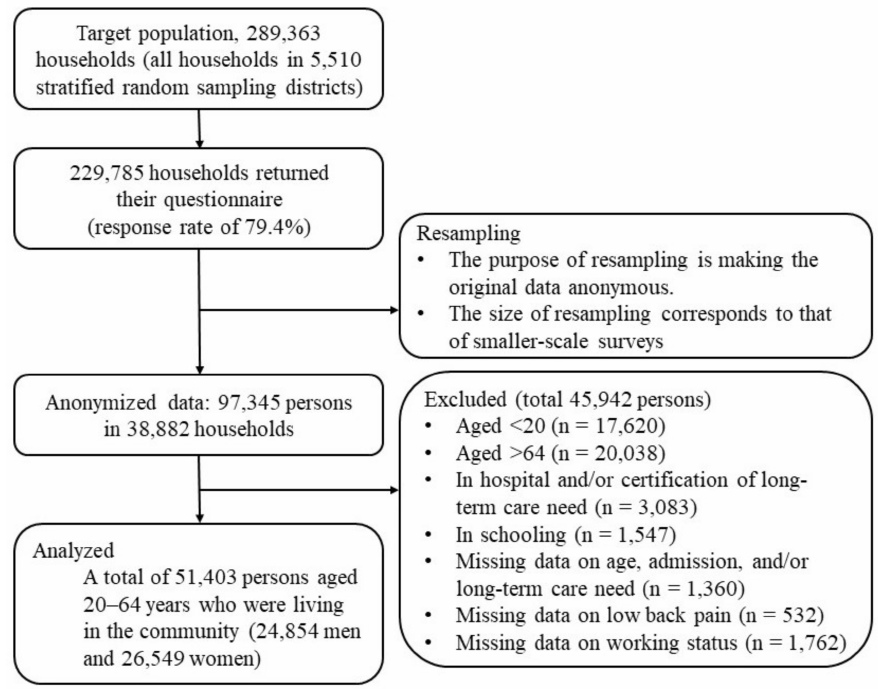
Figure 1. Selection of study